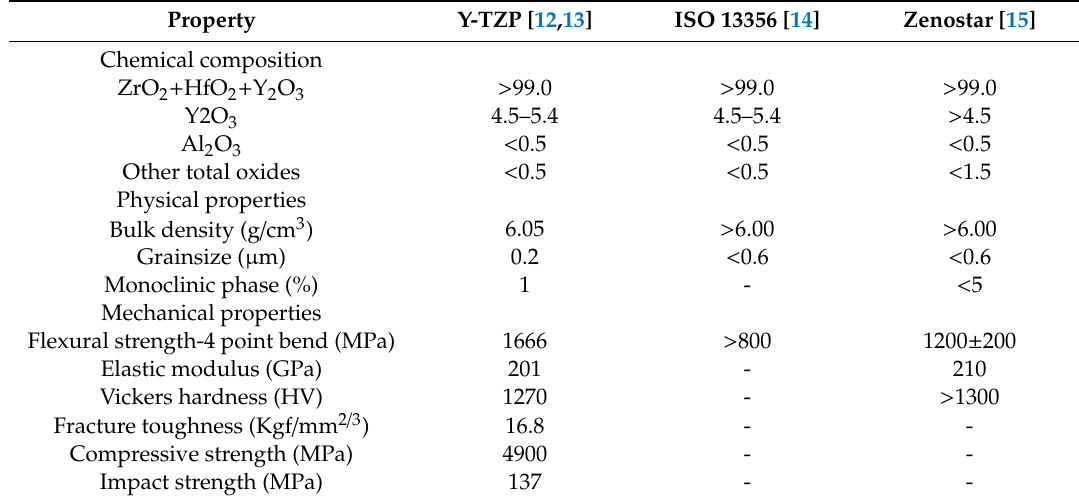
Table 2. Properties of zirconiadental